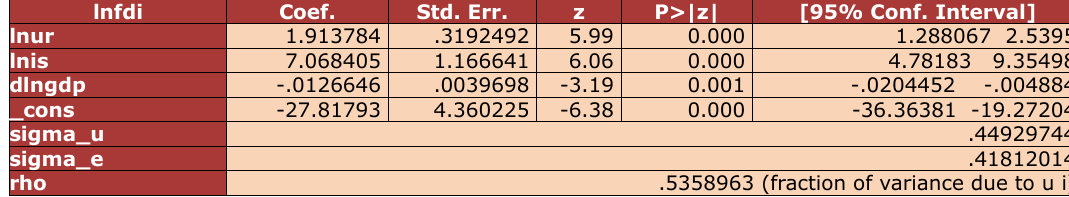
Table 6. The result of Random effect model of panel